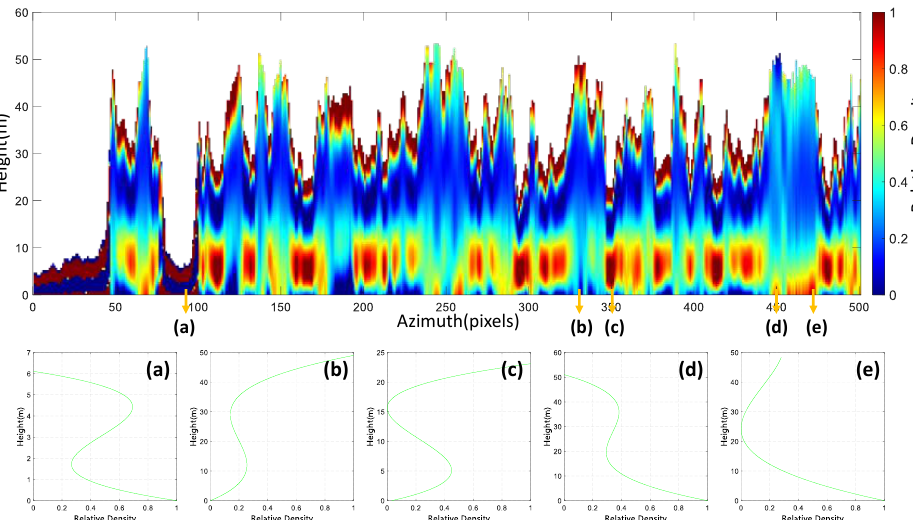
Figure 6. Inversion results of vertical profiles of tropical forests using dual-baseline PolInSAR data based on the PCT model. The top panel shows the vertical structural polarization tomogram of the area covered by the red line in the yellow rectangular box in Figure 7c and ( a – e ) represent the profile functions of the 90th, 31st, 350th, 450th, and 470th pixels, respectively, in the above polarization tomogram.